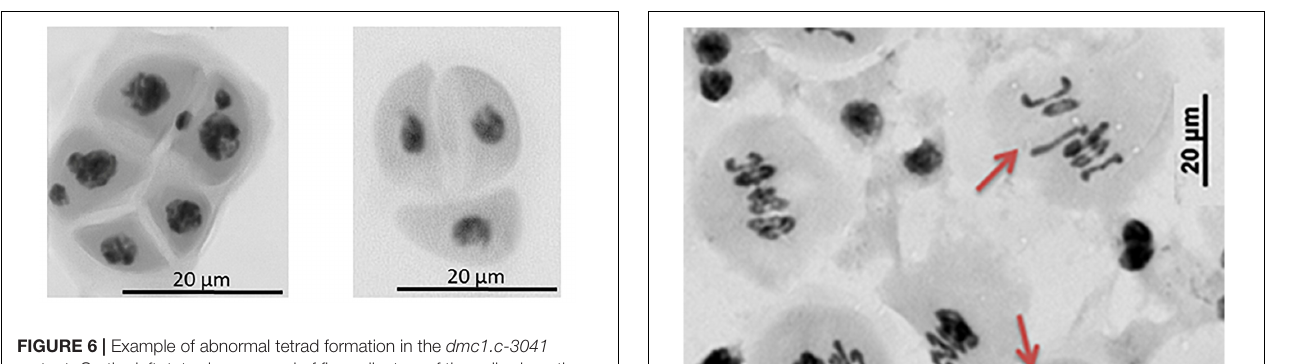
when compared to the wild type, whereas the dmc1.b mutant did